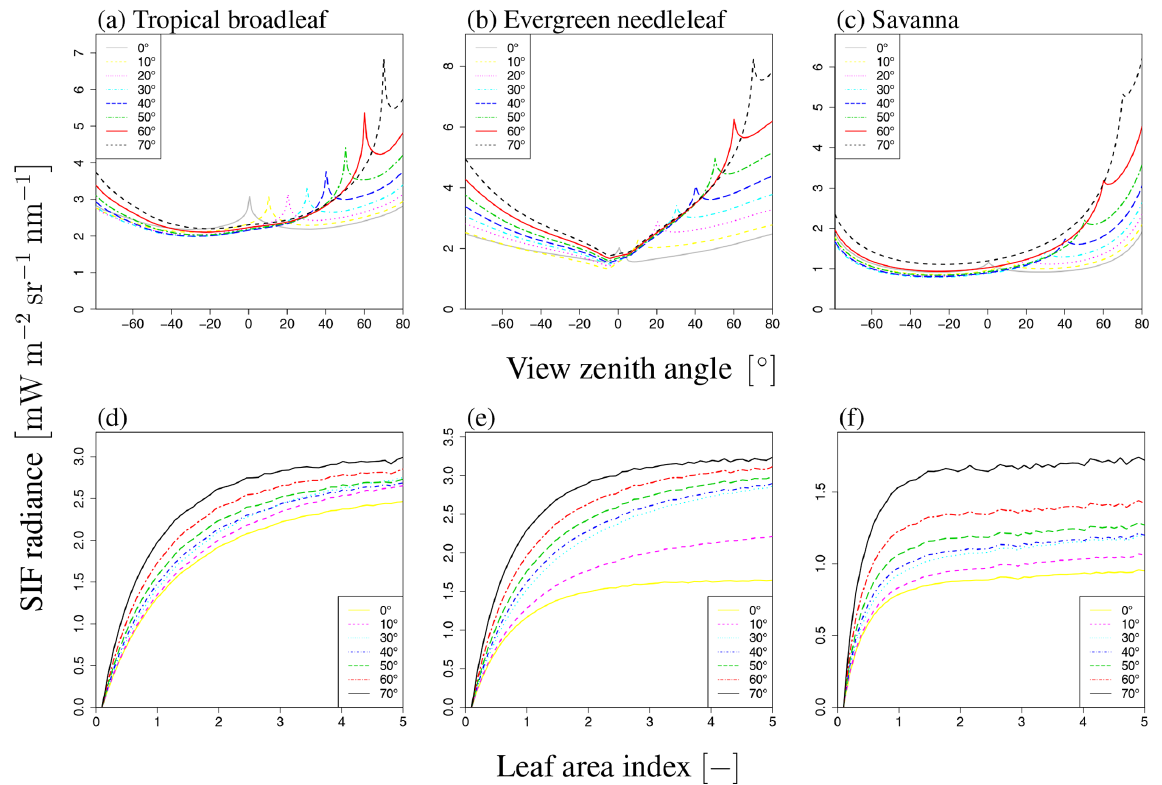
Figure 18. Comparison of SIF radiance with different landscapes. Panels (a) – (c) and (d) – (f) indicate VZA dependency (LAI of 3.0) and LAI dependency (VZA of 20 ◦ ), respectively. Each line represents a different SZA value (0–70 ◦ ).